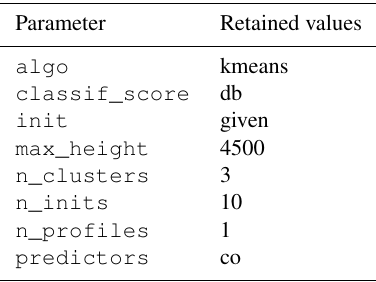
Table 3. Retained values for the parameters of the KABL code after the sensitivity analysis.